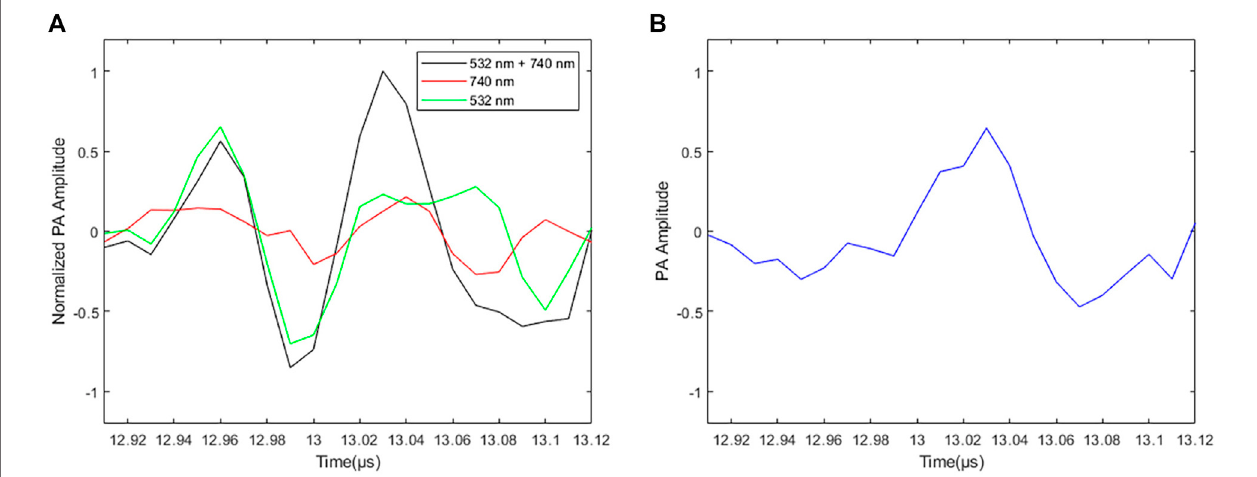
FIGURE5| Photoacousticsignalwith0.5 µstimedelay. (A) BlacklineisthePAsignaloftheglasstubewithPtOEPstimulatedby532and740 nmcombinedbeam. Red line isthe PA signal of the glass tube with PtOEP stimulated by 740 nm beam. Green line isthe PA signal of the glass tube with PtOEP stimulated by 532 nm beam. (B) The PA signal stimulated 532 and 740 nm combined beam subtracts the PA signal stimulated by 740 nm beam and then subtracts the PA signal using 532 nm beam, which is the TTD signal.